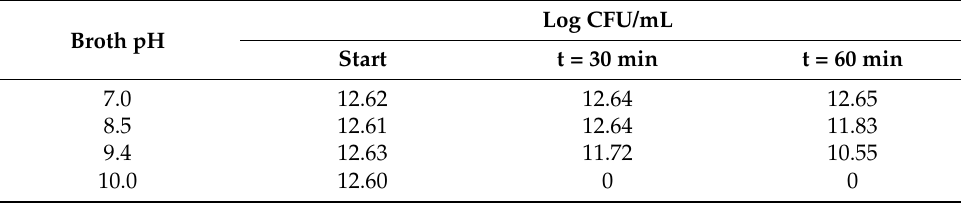
Table 3. Impact of broth pH on the number of bacteria in a fermenting glycerol solution. Broth